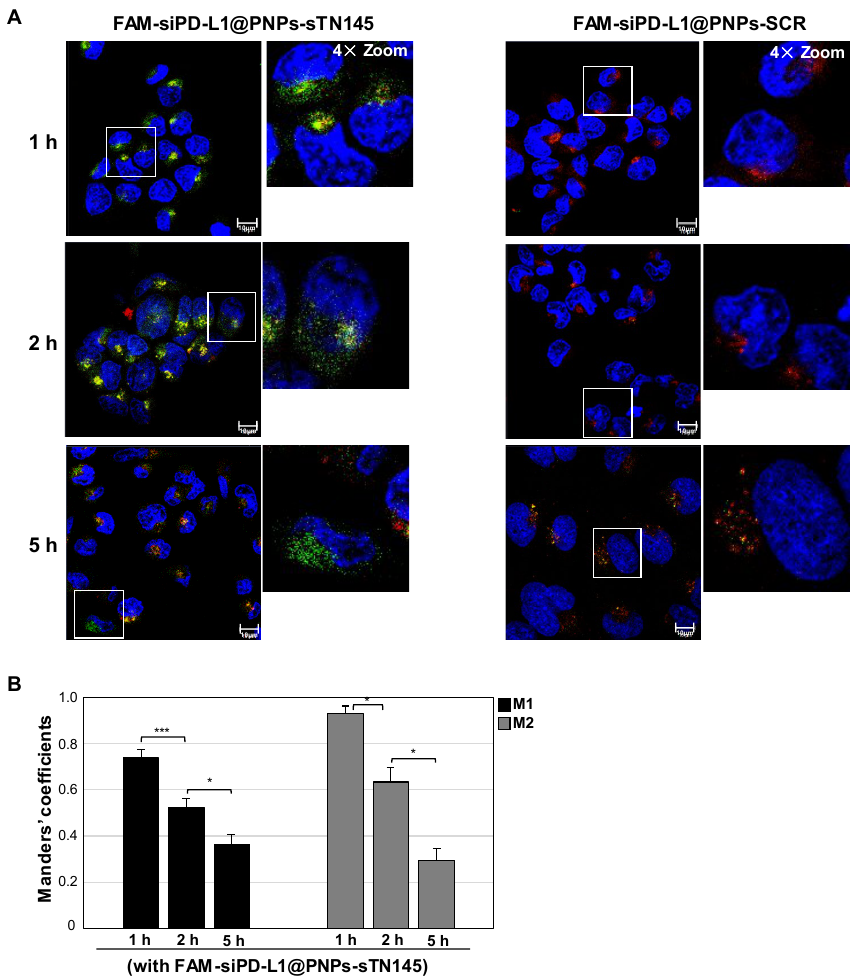
Figure 4. Selective cell uptake and release from endosomes of FAM-siPD-L1@PNPs-sTN145 compared to FAM-siPD-L1@PNPs-SCR. ( A ) Representative merged confocal images of BT-549 cells incubated for different periods (1 to 5 h) at 37 ◦ C with FAM-siPD-L1@PNPs-sTN145 or FAM-siPD-L1@PNPs-SCR after live-staining with LysoTracker Red for endosomes’ visualization. FAM-siPD-L1, LysoTracker, and nuclei are visualized in green, red, and blue, respectively. Co-localization results appear in yellow in the images. The white squares indicate the area shown in insets in a magnified view obtained using Image J software. Magnification 63 × , 1.0 × digital zoom, scale bar = 10 µ m. Inset: 4 × digital zoom. All digital images were acquired with the same setup to allow direct comparison of staining patterns. ( B ) Quantitative analysis of colocalization of FAM-siPD-L1, in the presence of FAM-siPD-L1@PNPs-sTN145 treatment, with endosomes. Manders’ coefficient M1 quantifies the fraction of FAM-siPD-L1 signal overlapping with endosomal signal; M2 quantifies the fraction of endosomal signal overlapping with FAM-siPD-L1. M1 and M2 were quantified on 10 separate images for each incubation time. Bars depict means ± SD. * p < 0.05, *** p < 0.001 on a minimum of 100 cells for each